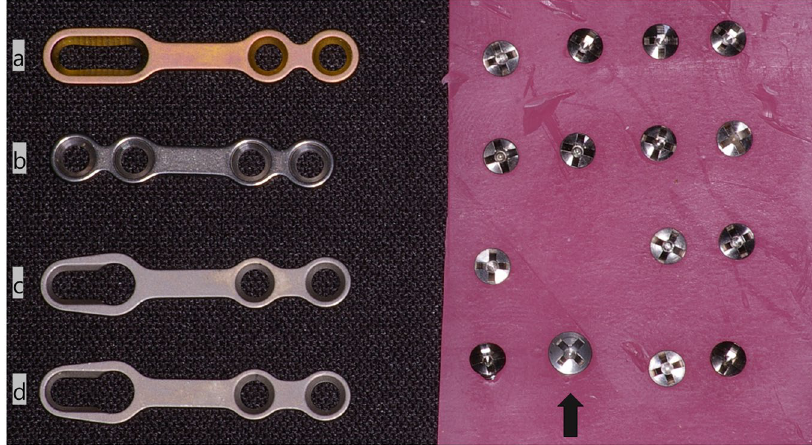
Figure 6. Four types of fixation after SSO. ( a ) Sliding-plate with four screws, ( b ) Four-hole bridge plate with four screws ( c ) YK-plate with three screws and ( d ) YK-plate with three screws and one oversized head screw (black